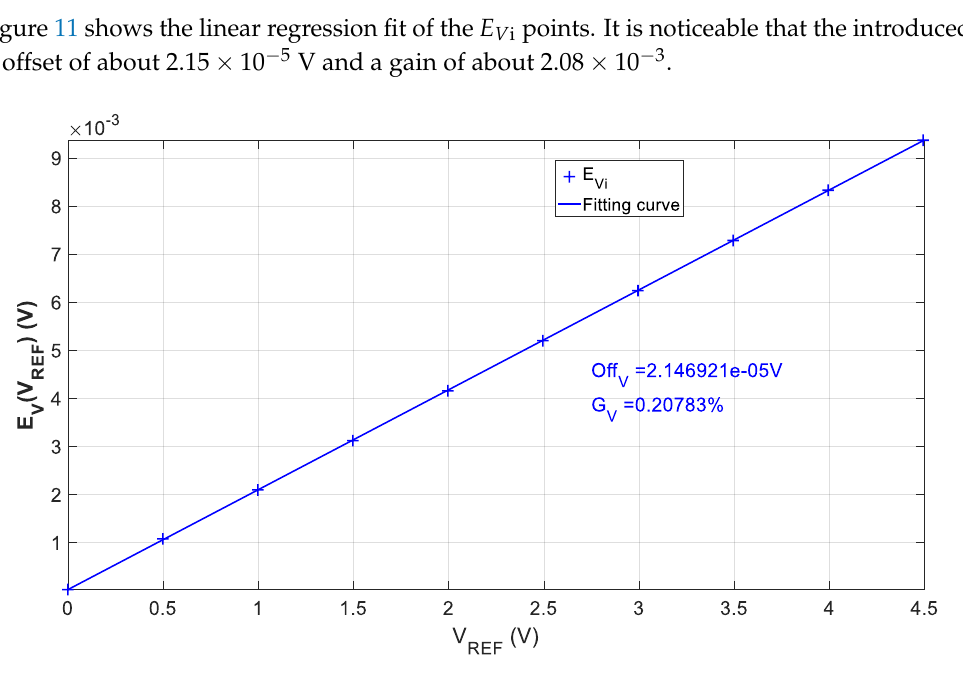
Figure 11. Linear regression function that best fits the voltage absolute error over ten values to determine the CST “trueness” on the entire input range.